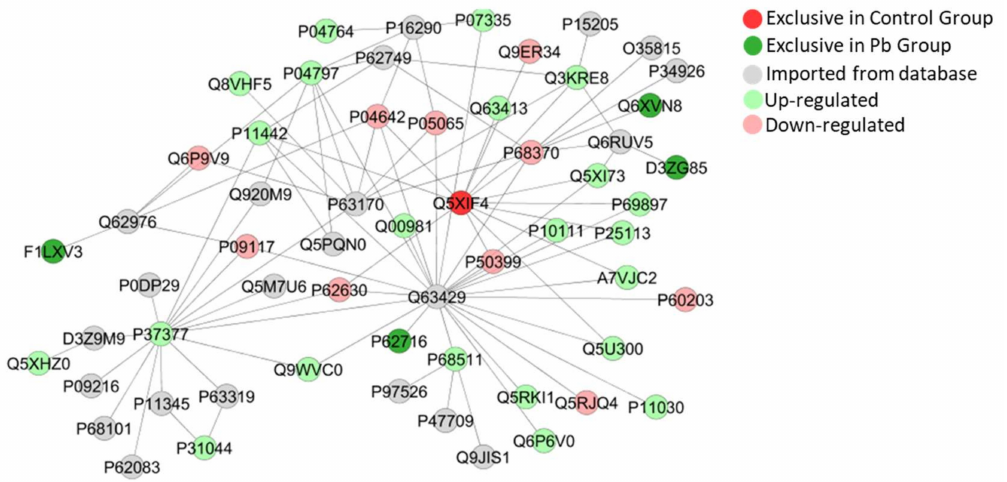
Figure 11. Sub-network created by ClusterMarker app to determine the interaction among identified proteins of the cerebellum with di ff erent expression on exposed group vs. control group, named by its accession ID from Uniprot. Serine / threonine kinase 26 (F1LXV3), Calcium-activated potassium channel subunit alpha-1 (Q62976), Tubulin alpha-1B chain (Q6P9V9), Clathrin heavy chain 1 (P11442), Citrate synthase, mitochondrial (Q8VHF5), Glyceraldehyde-3-phosphate dehydrogenase (P04797), Alpha-enolase (P04764), Hippocalcin-like protein 1 (P62749), Phosphoglycerate mutase 2 (P16290), Creatine kinase B-type (P07335), Aconitate hydratase, mitochondrial (Q9ER34), Microtubule-associated protein 1B (P15205), Tubulin beta-2B chain (Q3KRE8), Ataxin-3 (O35815), Microtubule-associated protein 1A (P34926), Microtubule-associated proteins 1A / 1B light chain 3A (Q6XVN8), Ras-related C3 botulinum toxin substrate 1 (Q6RUV5), Cyclin-dependent kinase-like 5 (D3ZG85), Rho GDP-dissociation inhibitor 1 (Q5XI73), Tubulin beta-5 chain (P69897), Phosphoglycerate mutase 1 (P25113), Peptidyl-prolyl cis-trans isomerase A (P10111), Rab GDP dissociation inhibitor beta (P50399), Heterogeneous nuclear ribonucleoproteins A2 / B1 (A7VJC2), Rab GDP dissociation inhibitor beta (P50399), Myelin proteolipid protein (P60203), Ubiquitin-like modifier-activating enzyme 1 (Q5U300), Acyl-CoA-binding protein (P11030), NAD-dependent protein deacetylase sirtuin-2 (Q5RJQ4), Glucose-6-phosphate isomerase (Q6P6V0), Eukaryotic initiation factor 4A-II (Q5RKI1), Regulating synaptic membrane exocytosis protein 2 (Q9JIS1), Rabphilin-3A (P47709), Neurofibromin (P97526), 14-3-3 protein eta (P68511), Serine / threonine-protein phosphatase 2A catalytic subunit beta isoform (P62716), Multidrug resistance protein1(Q63426), Septin-7(Q9WVC0), PhotosystemIreactioncentersubunitXI(P37277), Proteinkinase C gamma type (P63319), Phosphatidylethanolamine-binding protein 1 (P31044), RAF proto-oncogene serine / threonine-protein kinase (P11345), 40S ribosomal protein S7 (P62083), Eukaryotic translation initiation factor 2 subunit 1 (P68101), Protein kinase C epsilon type (P09216), Heat shock protein 75 kDa, mitochondrial (Q5XHZ0), PTEN induced putative kinase 1 (Predicted) (D3Z9M9), Photosystem I reaction center subunit (XIP37277), Calmodulin-1 (P0DP29), Fructose-bisphosphate aldolase C (P09117), Actin-related protein 2 (Q5M7U6), Elongation factor 1-alpha 1 (P62630), Neurocalcin-delta (Q5PQN0), Dynein light chain 1, cytoplasmic (P63170), Ubiquitin carboxyl-terminal hydrolase isozyme L1 (Q00981), Small ubiquitin-related modifier 3 (Q5XIF4), L-lactate dehydrogenase A chain (P04642), Fructose-bisphosphate aldolase A (P05065), Spliceosome RNA helicase Ddx39b (Q63413) and Tubulin alpha-1A chain